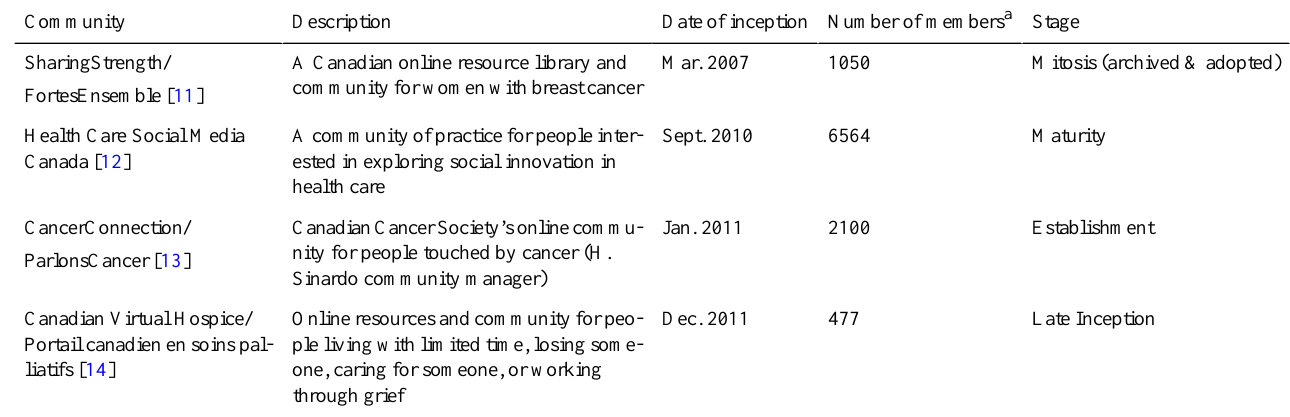
StageNumber of members a Date of inceptionDescriptionCommunity